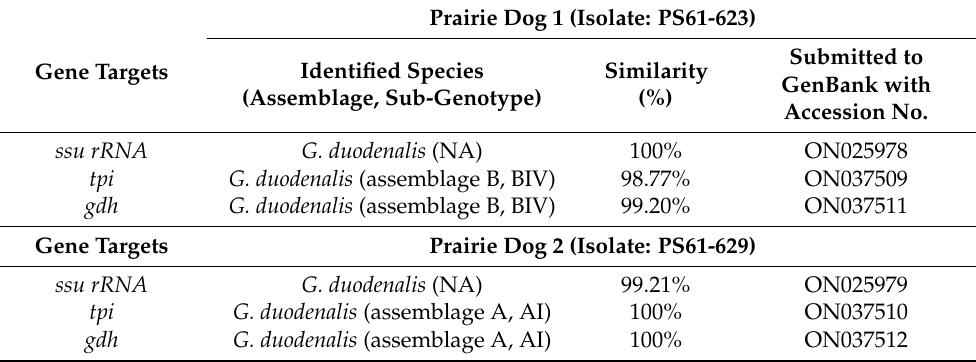
Table 3. Genetic characterization of G. duodenalis in pet prairie